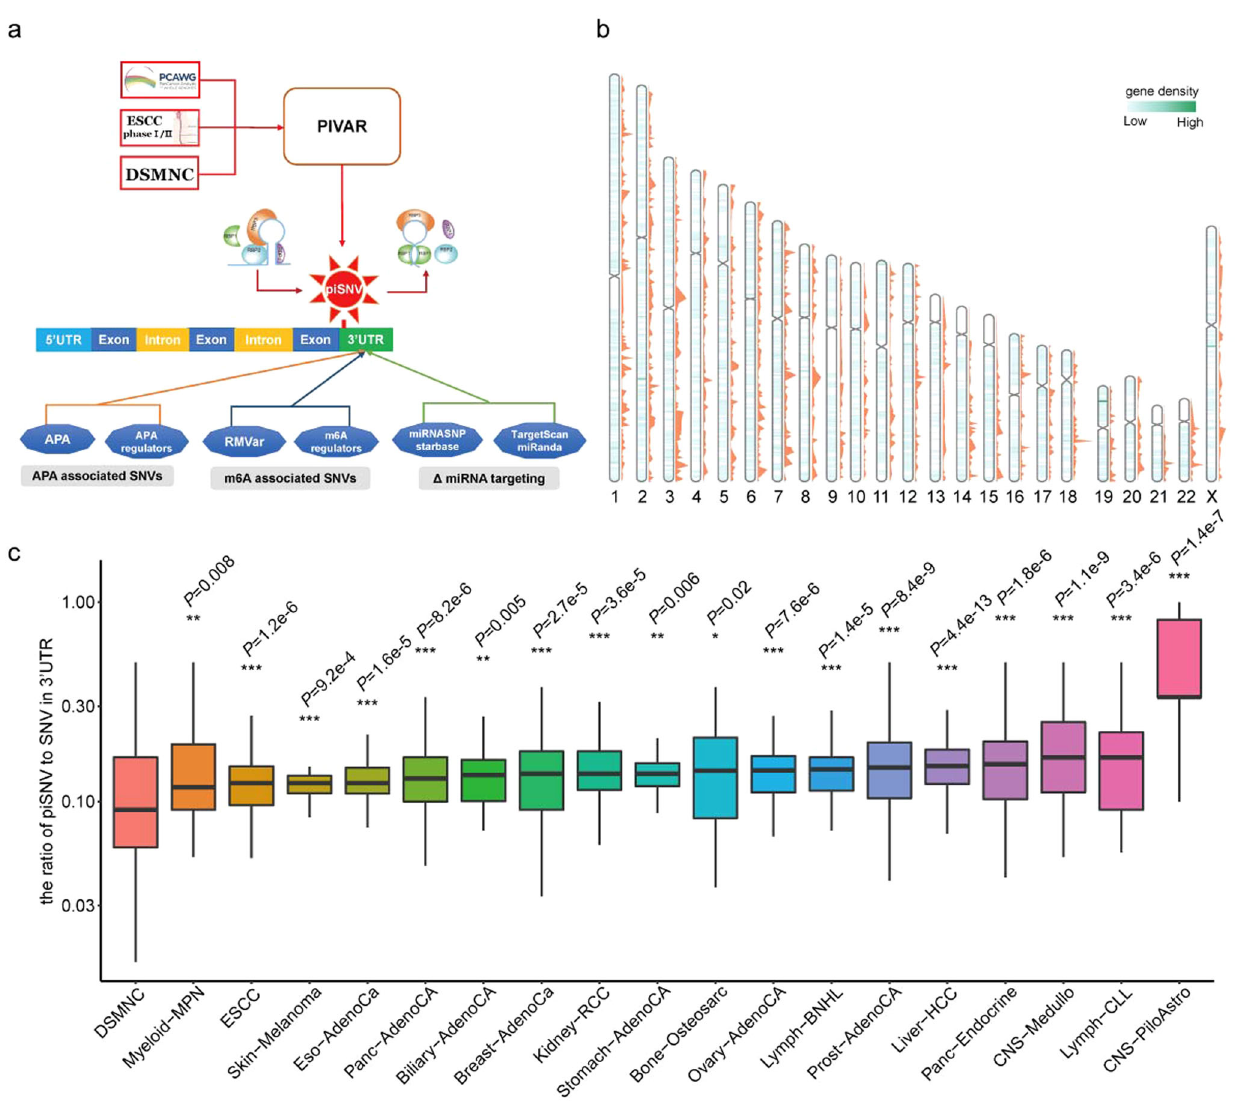
Fig. 1 3 ′ -UTR post-transcriptional impaired SNVs (3 ′ -UTR piSNVs) identi fi ed in PCAWG project and ESCC cohorts. a General work fl ow for identifying 3 ′ -UTR post-transcriptional impaired SNVs. b Genome-wide gene density distribution of identi fi ed piSNVs (blue lines in chromosome body) and 3 ′ -UTR piSNVs (orange peaks) in each chromosome. c Compared to controls in the DSMNC database, the proportion of somatic 3 ′ -UTR piSNVs was signi fi cantly elevated in the PCAWG project and ESCC cohorts (* P < 0.05, ** P < 0.01, *** P < 0.001). We calculated the ratio of piSNV to SNV in 3 ′ -UTR for each sample, and used wilcoxon rank-sum test to evaluate the distribution differences of 3 ′ -UTR piSNV ratio between cancer samples in each cancer type and control samples. Boxplots elements represent: center line = median, upper and lower hinges = 25 and 75% percentiles, upper and lower whisker = mean ±